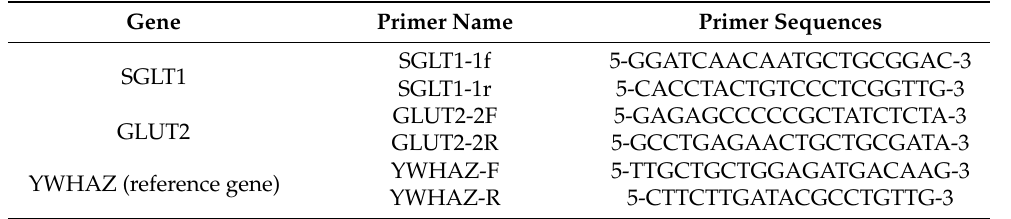
Table 4. Primer sequences.